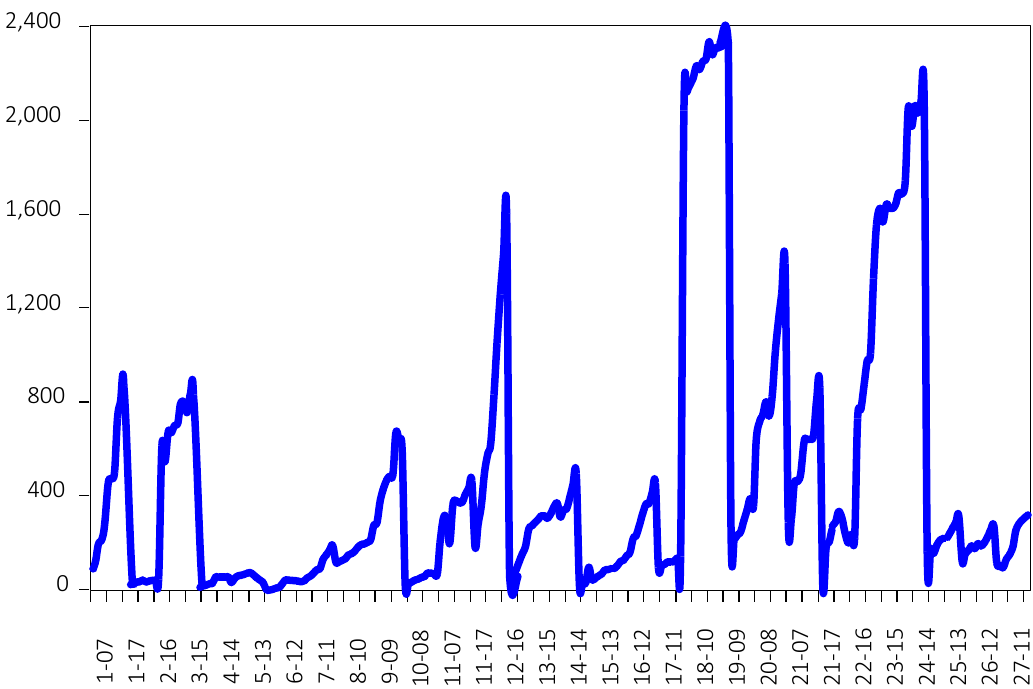
Figure 1. Line graph showing movements of financial inclusion by